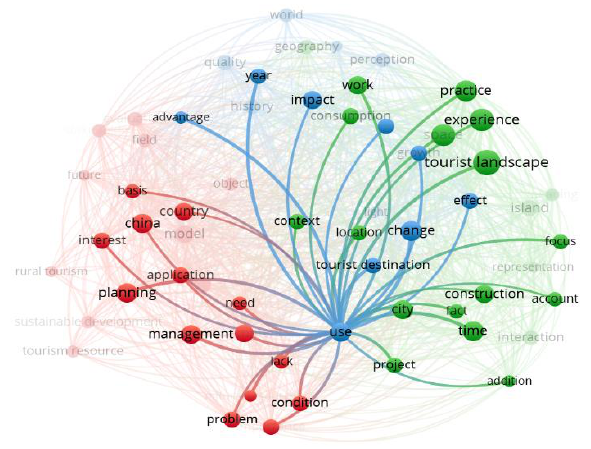
Figure 7. Co- occurrence term map by VOSviewer. Focus on the recurrent keyword: “Use”. Figure 7. Co-occurrence term map by VOSviewer. Focus on the recurrent keyword: